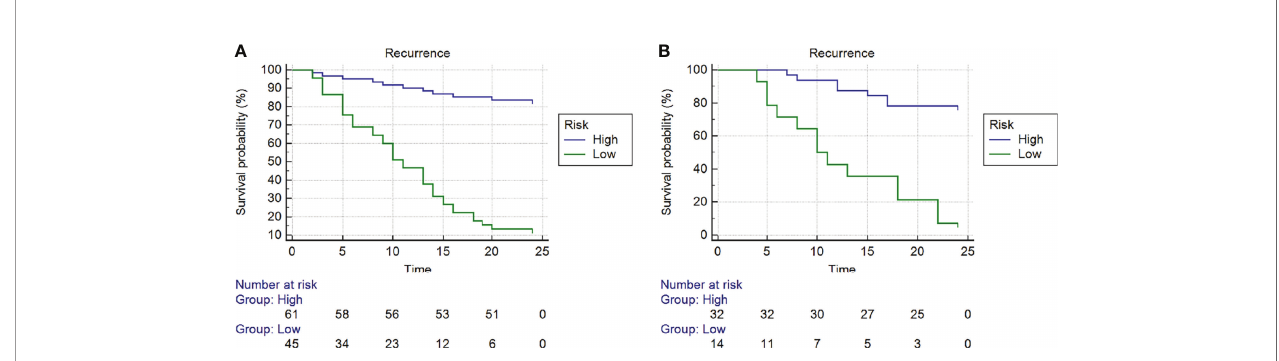
FIGURE 7 | Kaplan-Meier curves of recurrence-free survival (RFS) of high- and low- risk subgroups according to the cut-off value of nomogram in the (A) training cohort and (B) training